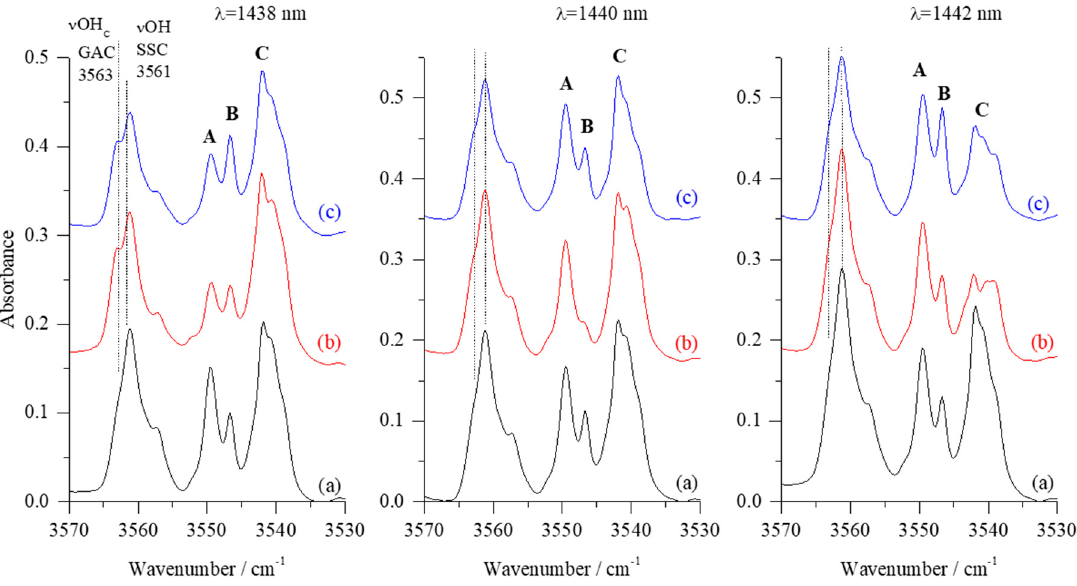
Figure 2. The ν OH regions of the infrared spectra obtained for the 1:1 complex formed between SSC and N 2 (SSC1): ( a ) After co-deposition GA with N 2 / Ar = 1 / 4000 at 18 K (10 K for measurement); ( b ) upon 360 min irradiation at 1438, 1440, or 1442 nm; ( c ) upon annealing at 33 K / 10 K. The perpendicular broken lines show position of the bands due to the GA monomer species. A, B and C stand for different trapping sites of GA…N 2 .